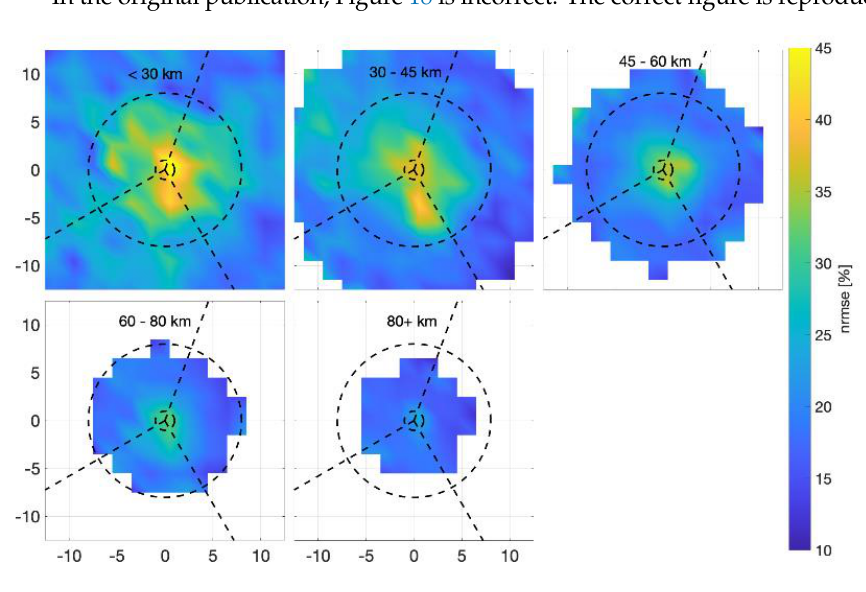
Figure 18. As in Figure 14, each subplot parsed by radius of maximum